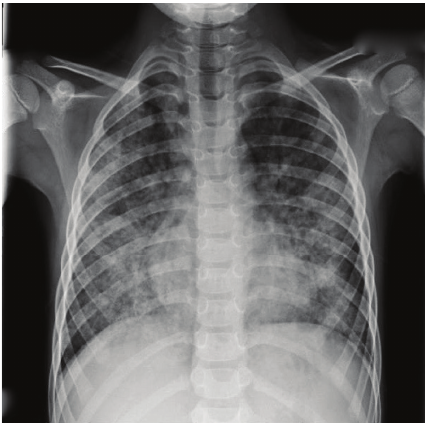
Figure 1: Posteroanterior chest radiography showing diffuse bilat- eral pulmonary infiltrations.